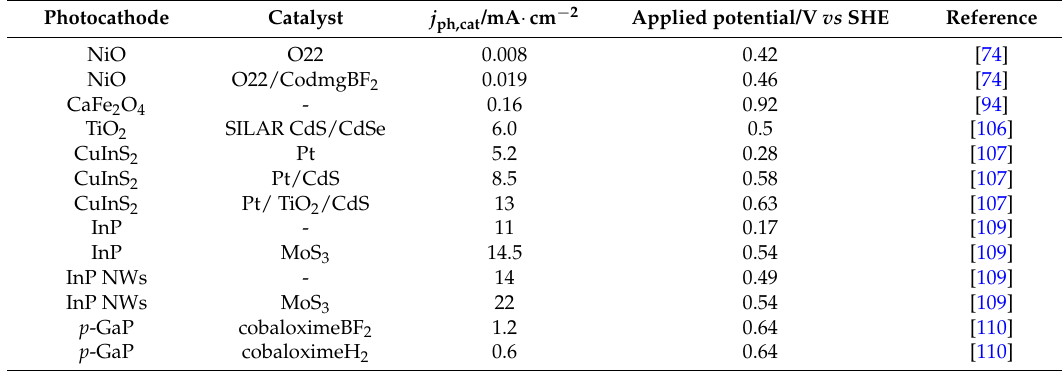
Table 3. Semiconducting electrodes, photoelectrocatalytic agents and conditions of photoelectrolysis for water splitting and H 2 production.